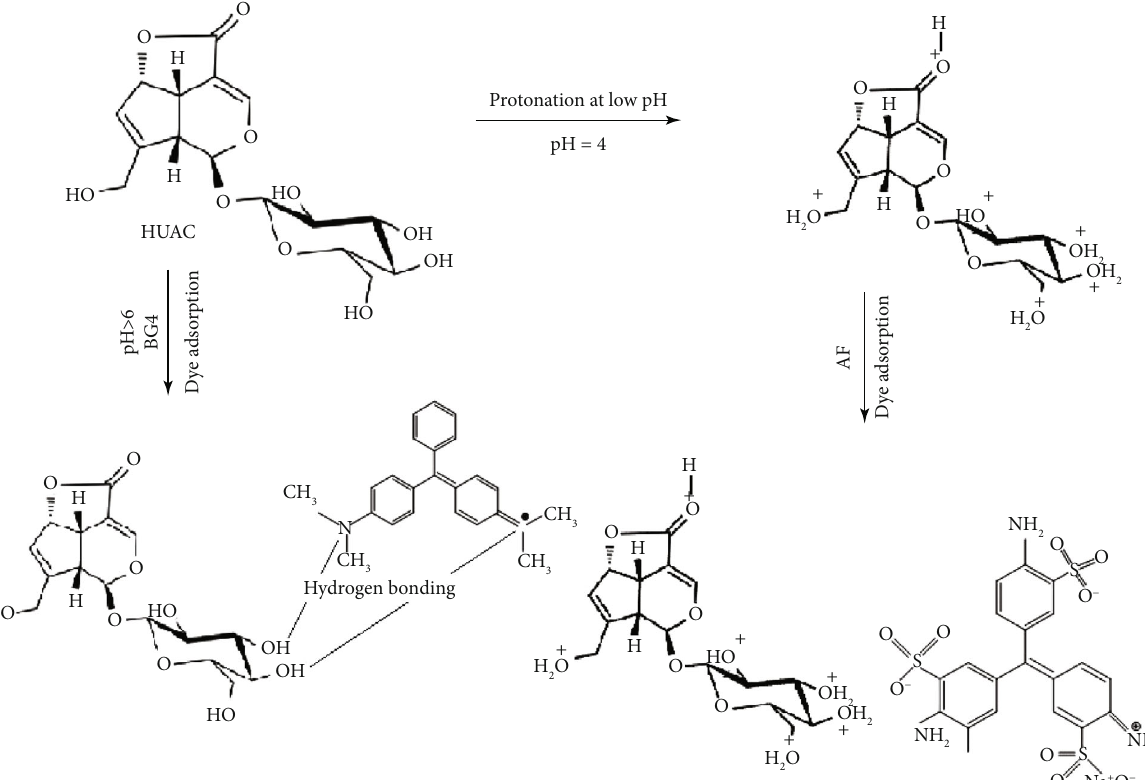
Figure 6: Proposed mechanism for adsorption of BG4 and AF dyes on HUAC.